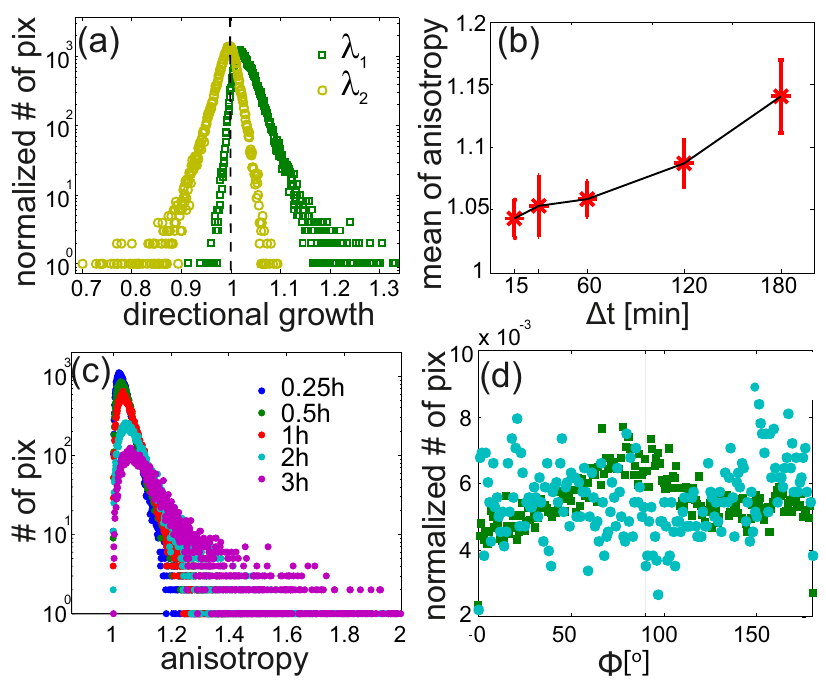
(cid:5) (cid:6) for the minimal time